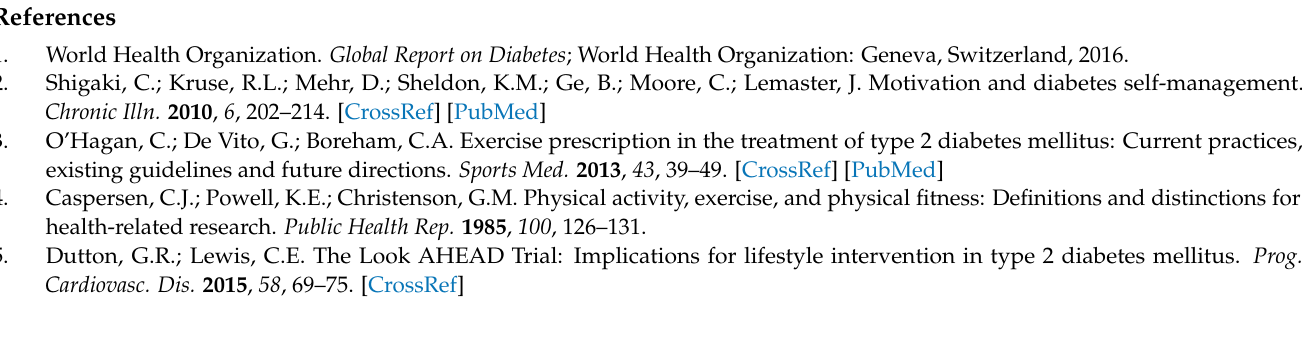
status; Table S2: Baseline intensity of PA by HbA1c levels in the study participants, Figure S1: Exercise module in the PRIDE